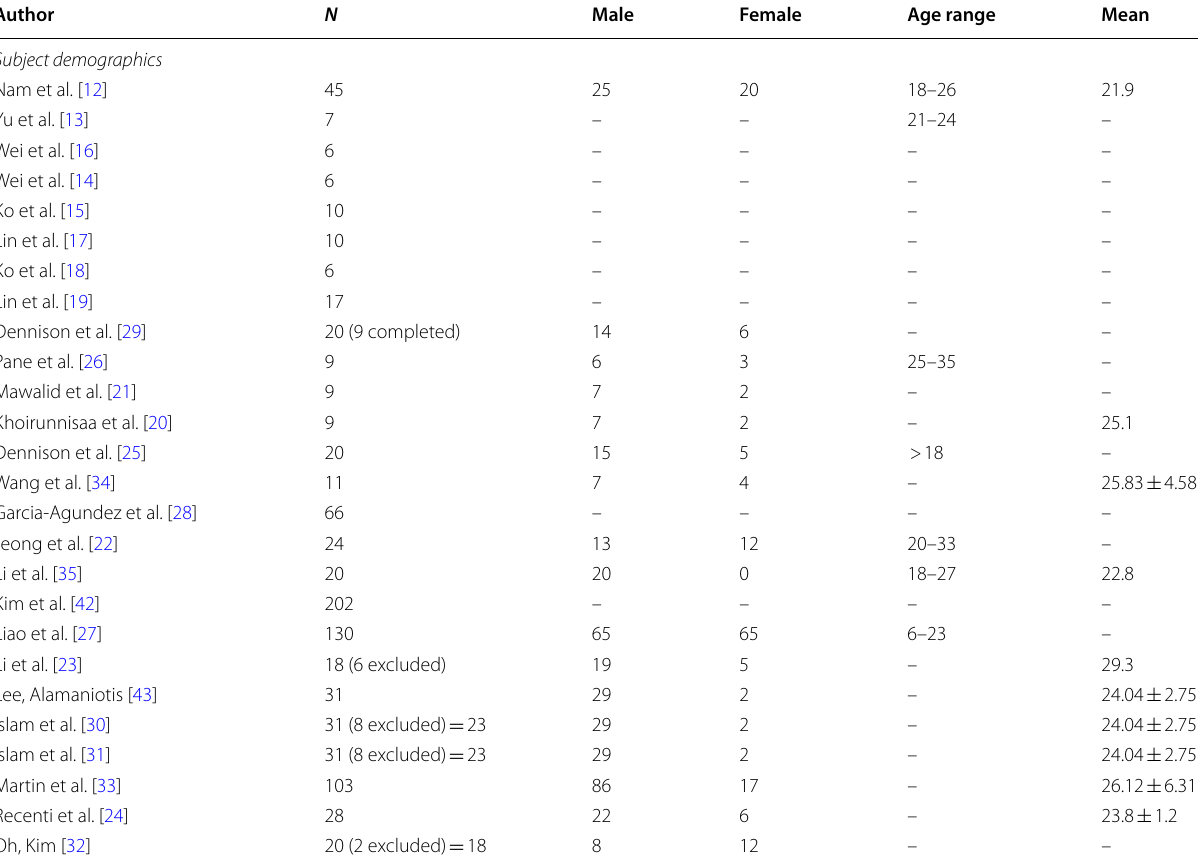
Table 3 Subject demographic including sample size, gender, age range and mean with standard deviation where